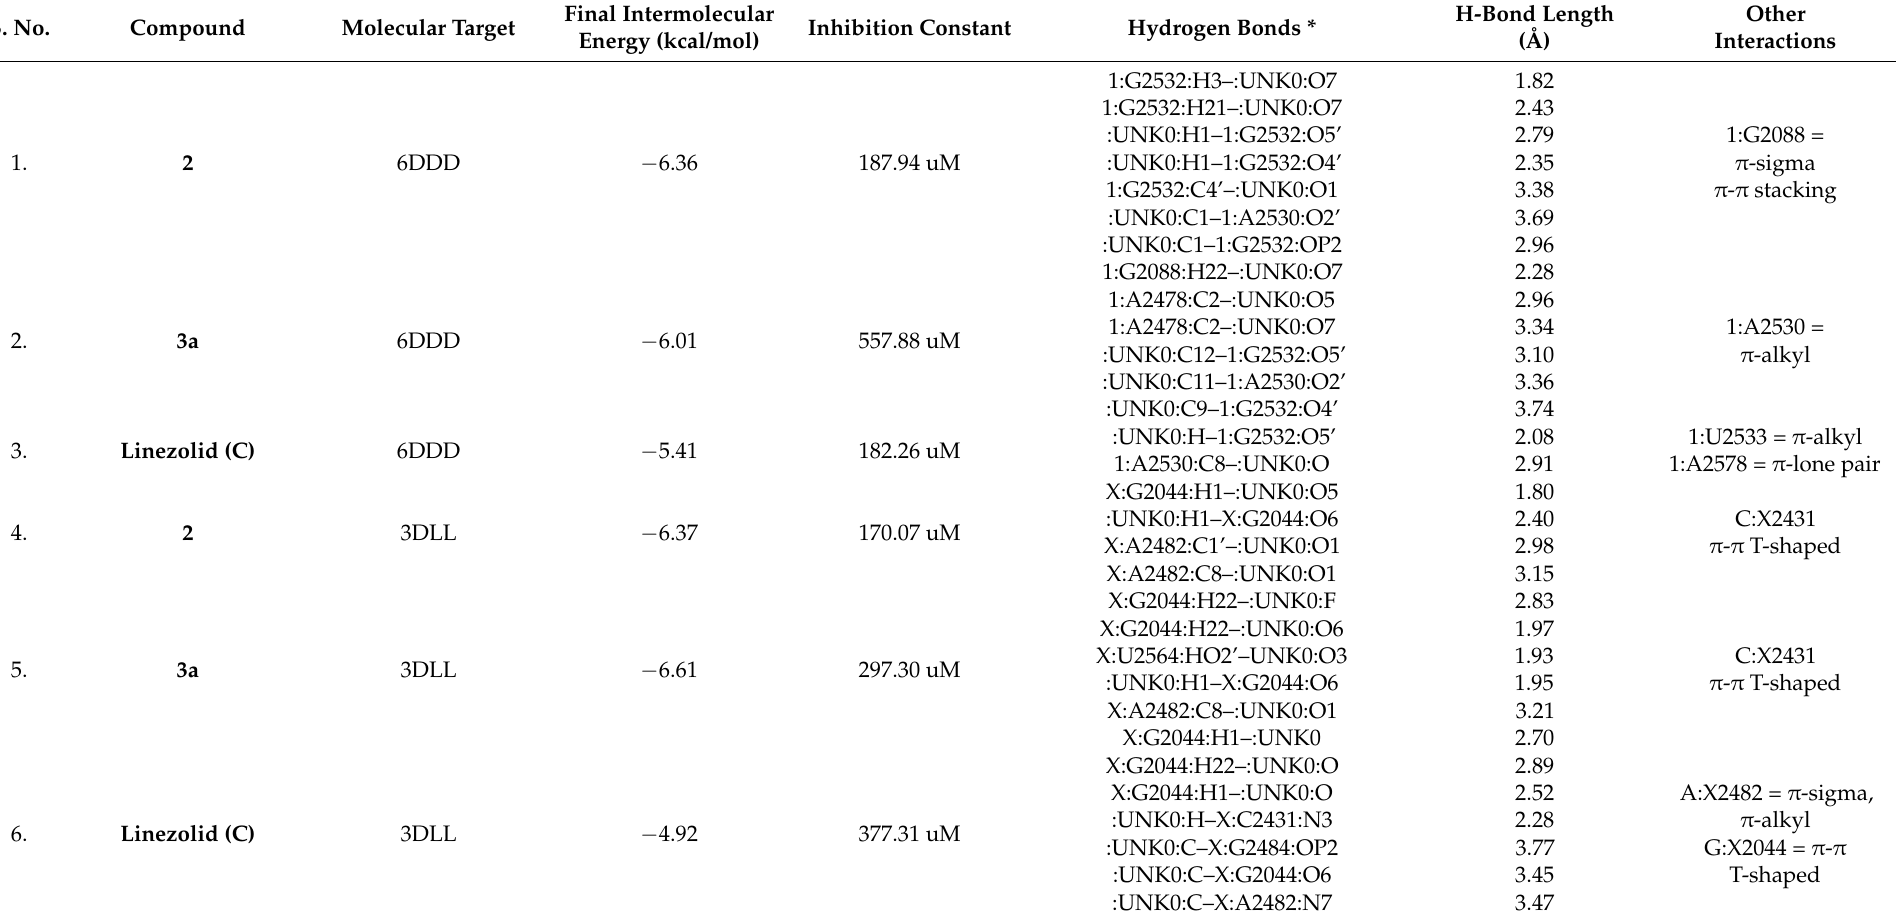
Table 4. Docking analysis of active conjugates ( 2 and 3a ) with ribosomal-based molecular targets. S.